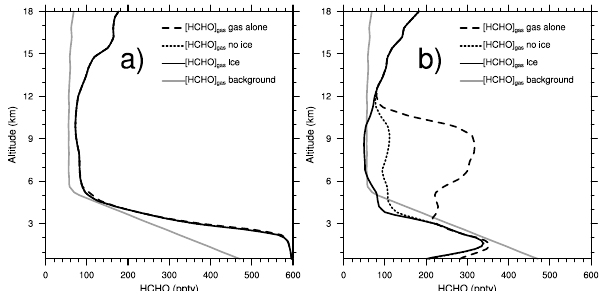
Figure 8. COPT case: vertical profiles of gas phase mixing ratio of formaldehyde: black lines 2 Fig. 8. COPT case – vertical profiles of gas phase mixing ratio are mixing ratio for GAS (dashed line), AQ-NOICE (dotted line) and AQ-ICE (solid line) 3 of formaldehyde: black lines are mixing ratio for GAS simula- tion (dashed line), AQ-NOICE simulation (dotted line) and AQ-ICE simulations and the solid grey line is the mixing ratio for the background troposphere, (a) in 4 simulation (solid line), for simulations, and the solid grey line is the the inflow region (20 km in horizontal distance) of the squall line during its mature stage, (b) 5 mixing ratio for the background troposphere (a) in the inflow region in the outflow region (200 km in horizontal distance) of the squall line during its mature 6 (20km in horizontal distance) of the squall line during its mature stage. 7 stage and (b) in the outflow region (200km in horizontal distance) of the squall line during its mature